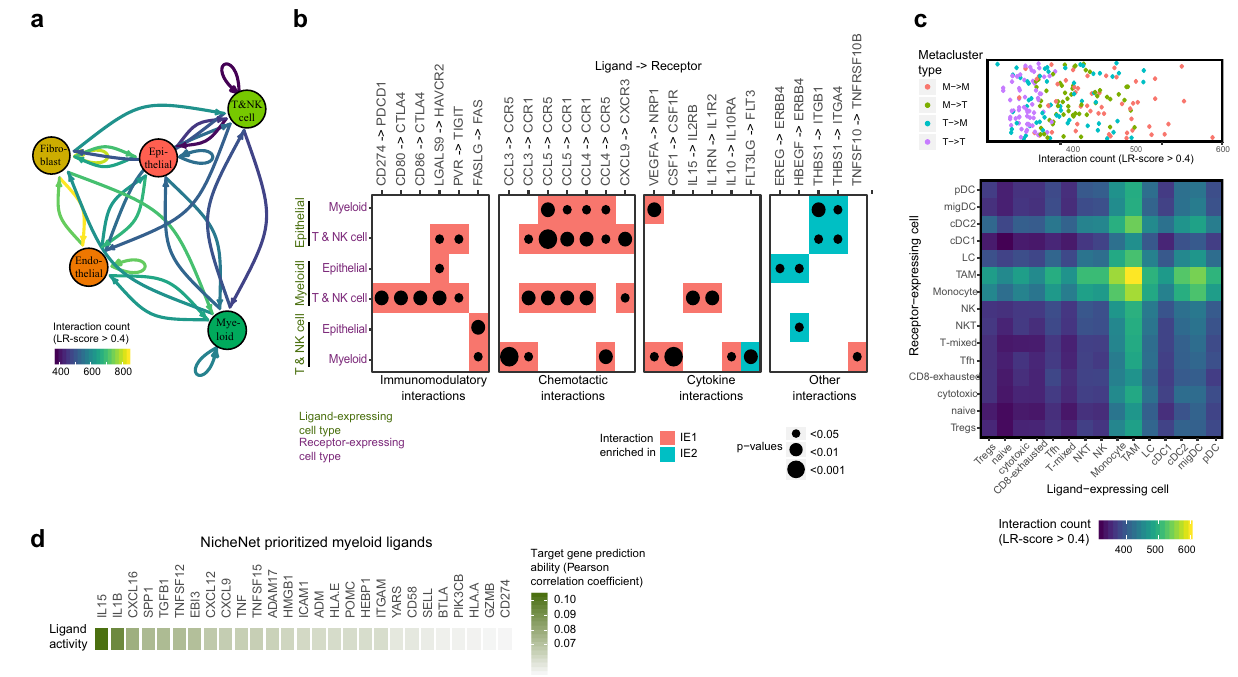
Fig. 5 | Ligand-receptor analysis predicts TIME-wide and exhaustion-speci fi c cellular crosstalk. a Social graph depicting the number of interactions between the fi ve most frequent cell types. b Enrichment of selected ligand-receptor inter- actionsineitherIE1orIE2tumorsforthegivencelltypepairs.Selectionsweremade basedonliteratureevidenceandbiologicalinterpretability.Thefulllistofenriched interaction pairs is in Supplementary Data 6. White squares denote interactions withanenrichment p value>0.05orameanLRscore<0.4inthegivencelltypepair.